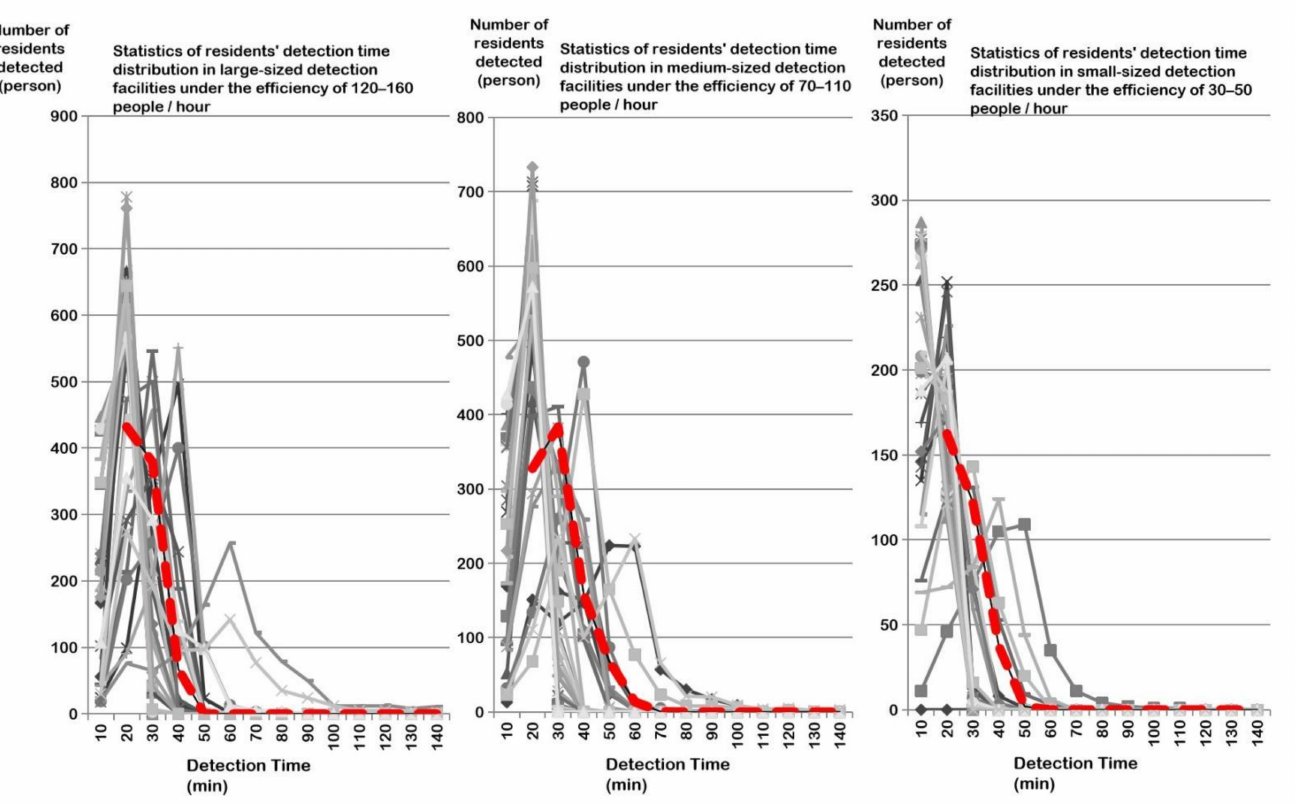
Figure 8. Statistical chart of residents’ time distribution in community primary testing at the efficiency of three levels (30 times for each